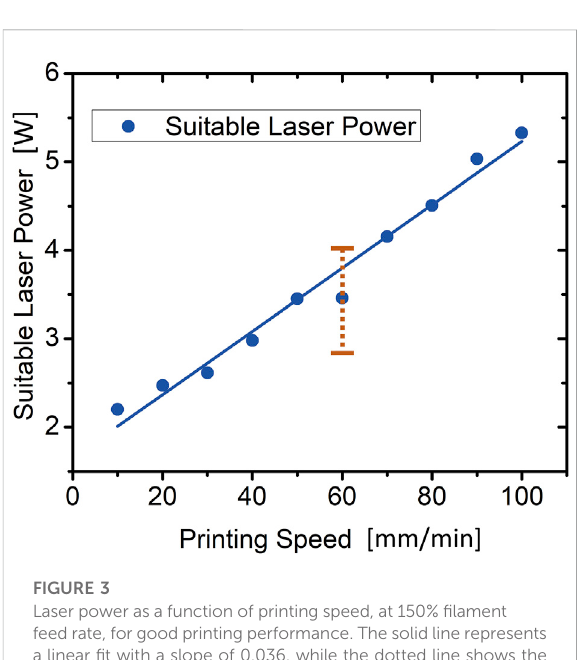
FIGURE 3 Laser power as a function of printing speed, at 150% fi lament feed rate, for good printing performance. The solid line represents a linear fi t with a slope of 0.036, while the dotted line shows the P-range(betweenP+andP-)ofsuitablepowerwhenprinting at 60